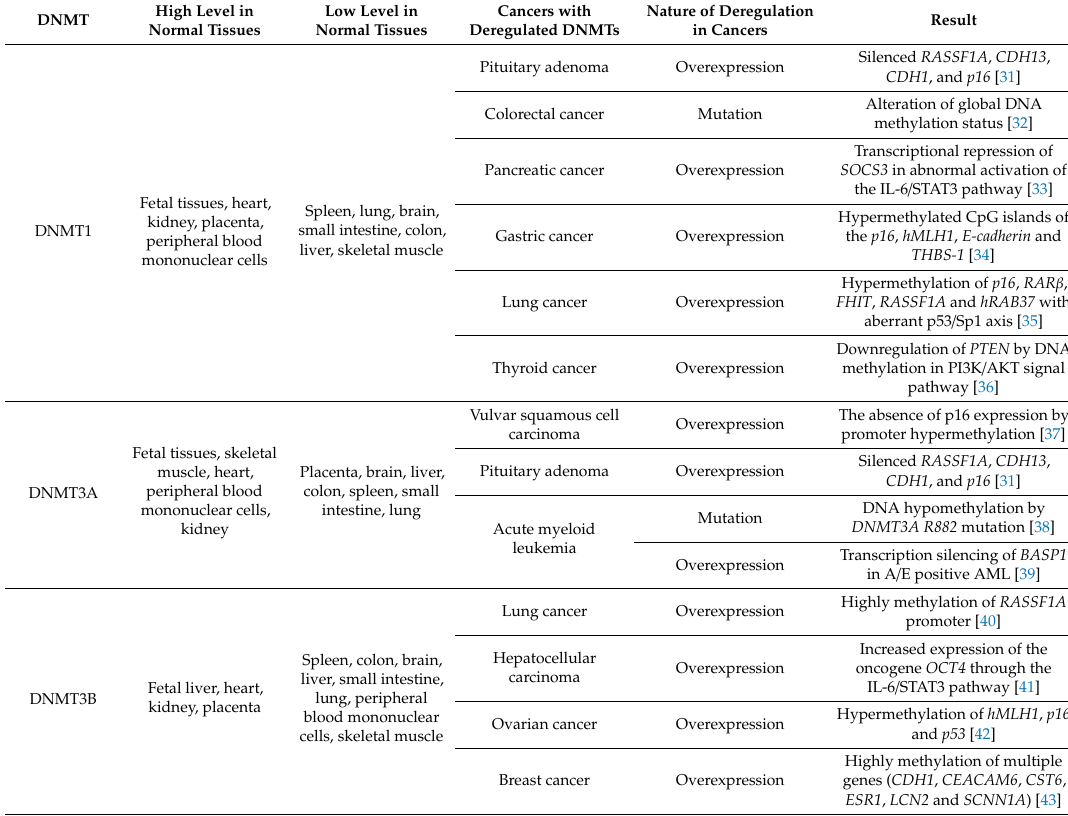
Table 1. Expression levels of DNMTs in normal tissues and deregulation of DNMTs in